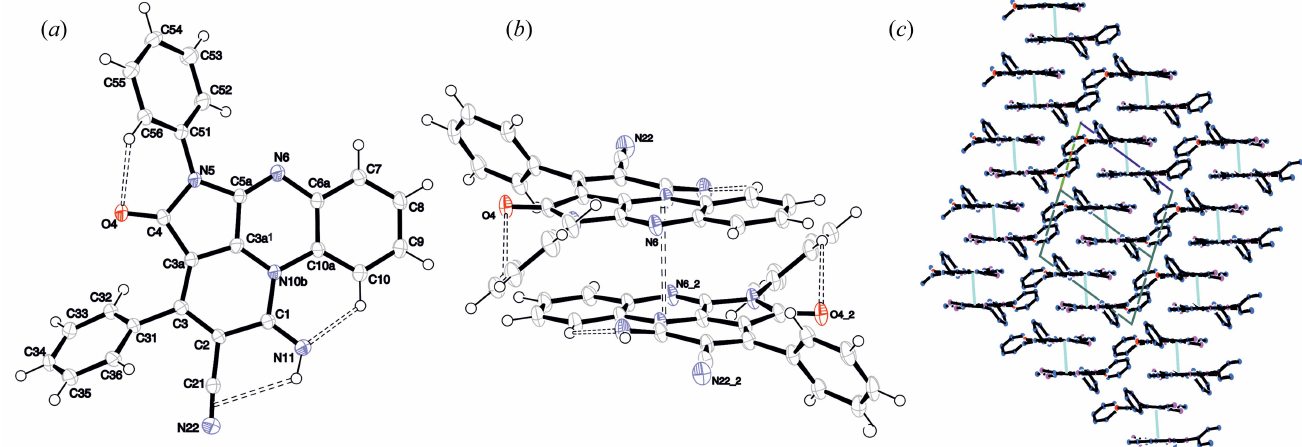
Figure 3 The molecular structure of TAAP ( a ) with the relevant atom-numbering scheme. The non-hydrogen atoms are represented as displacement ellipsoids plotted at the 30% probability level. ( b ) Side-by-side arrangement of two neighbouring chromophores with an interplanar distance of 3.413 A˚ . Intramolecular hydrogen bonds and the gravity centre distance are marked by dashed lines. ( c ) Packing scheme along [ 110]. Gravity-centre-to-gravity- centre distance for planar chromophores in the dimer is marked by a turquoize line. H atoms have been omitted for clarity and the unit cell is marked by a black